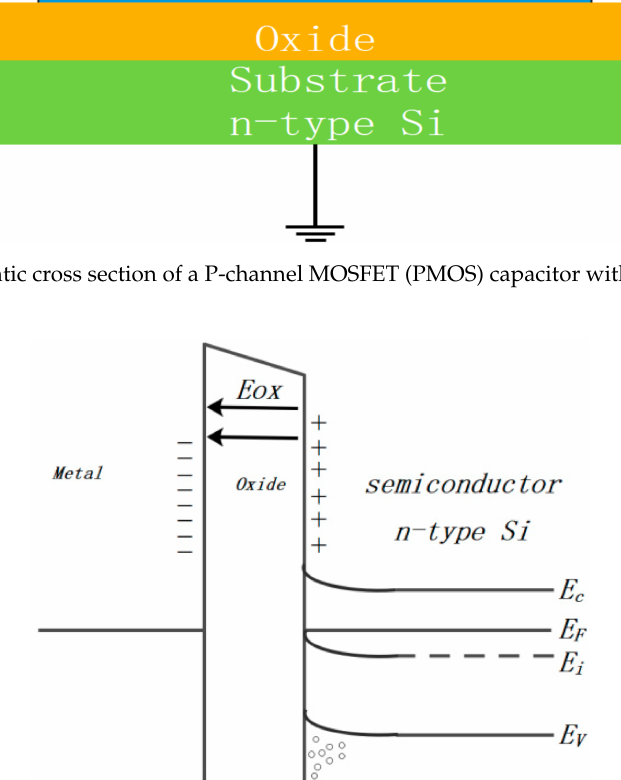
where t ox is the thickness of